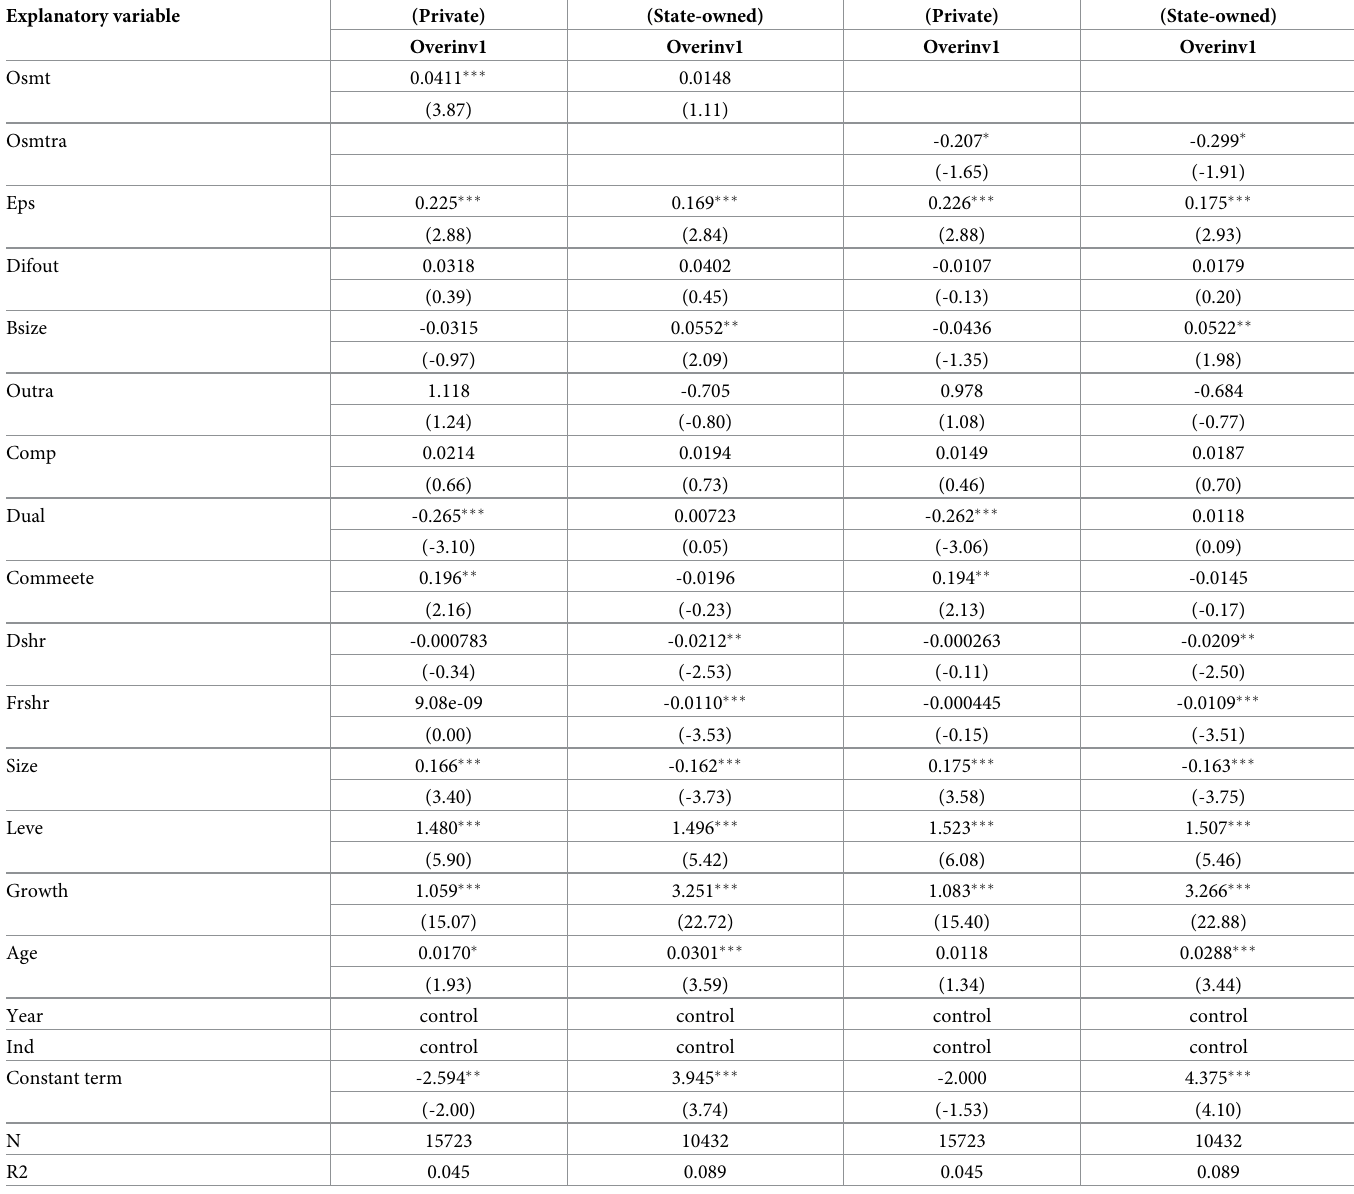
Table 7. The different nature of company’s